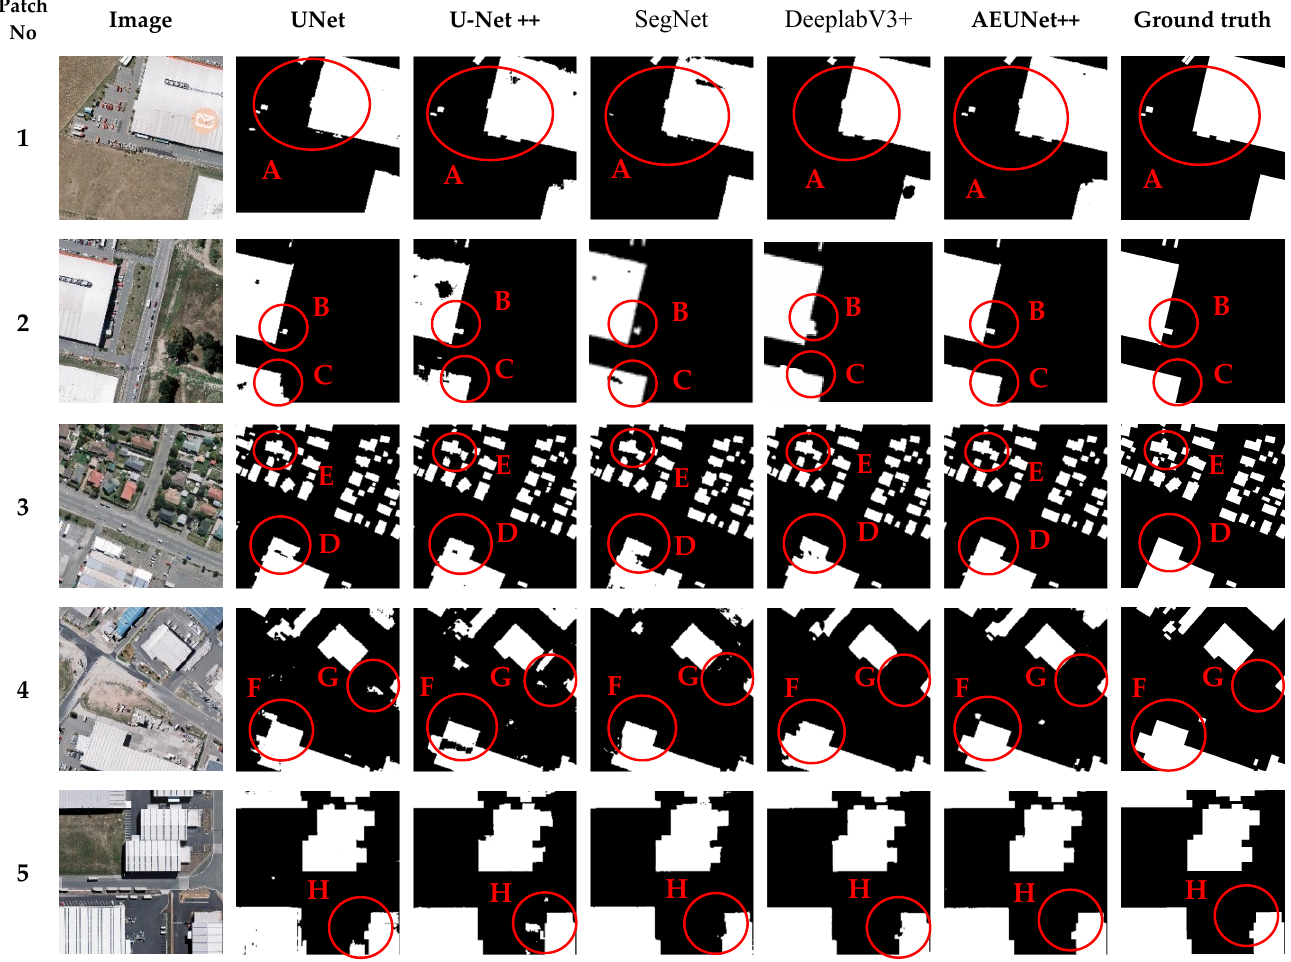
Figure 10. Segmented patches from U-Net, UNet++, SegNet, DeeplabV3+ and AEUNet++ based on the WHU aerial image data set. The white color in the segmented patches represents pixels belonging to buildings (A–H denote the marked areas).